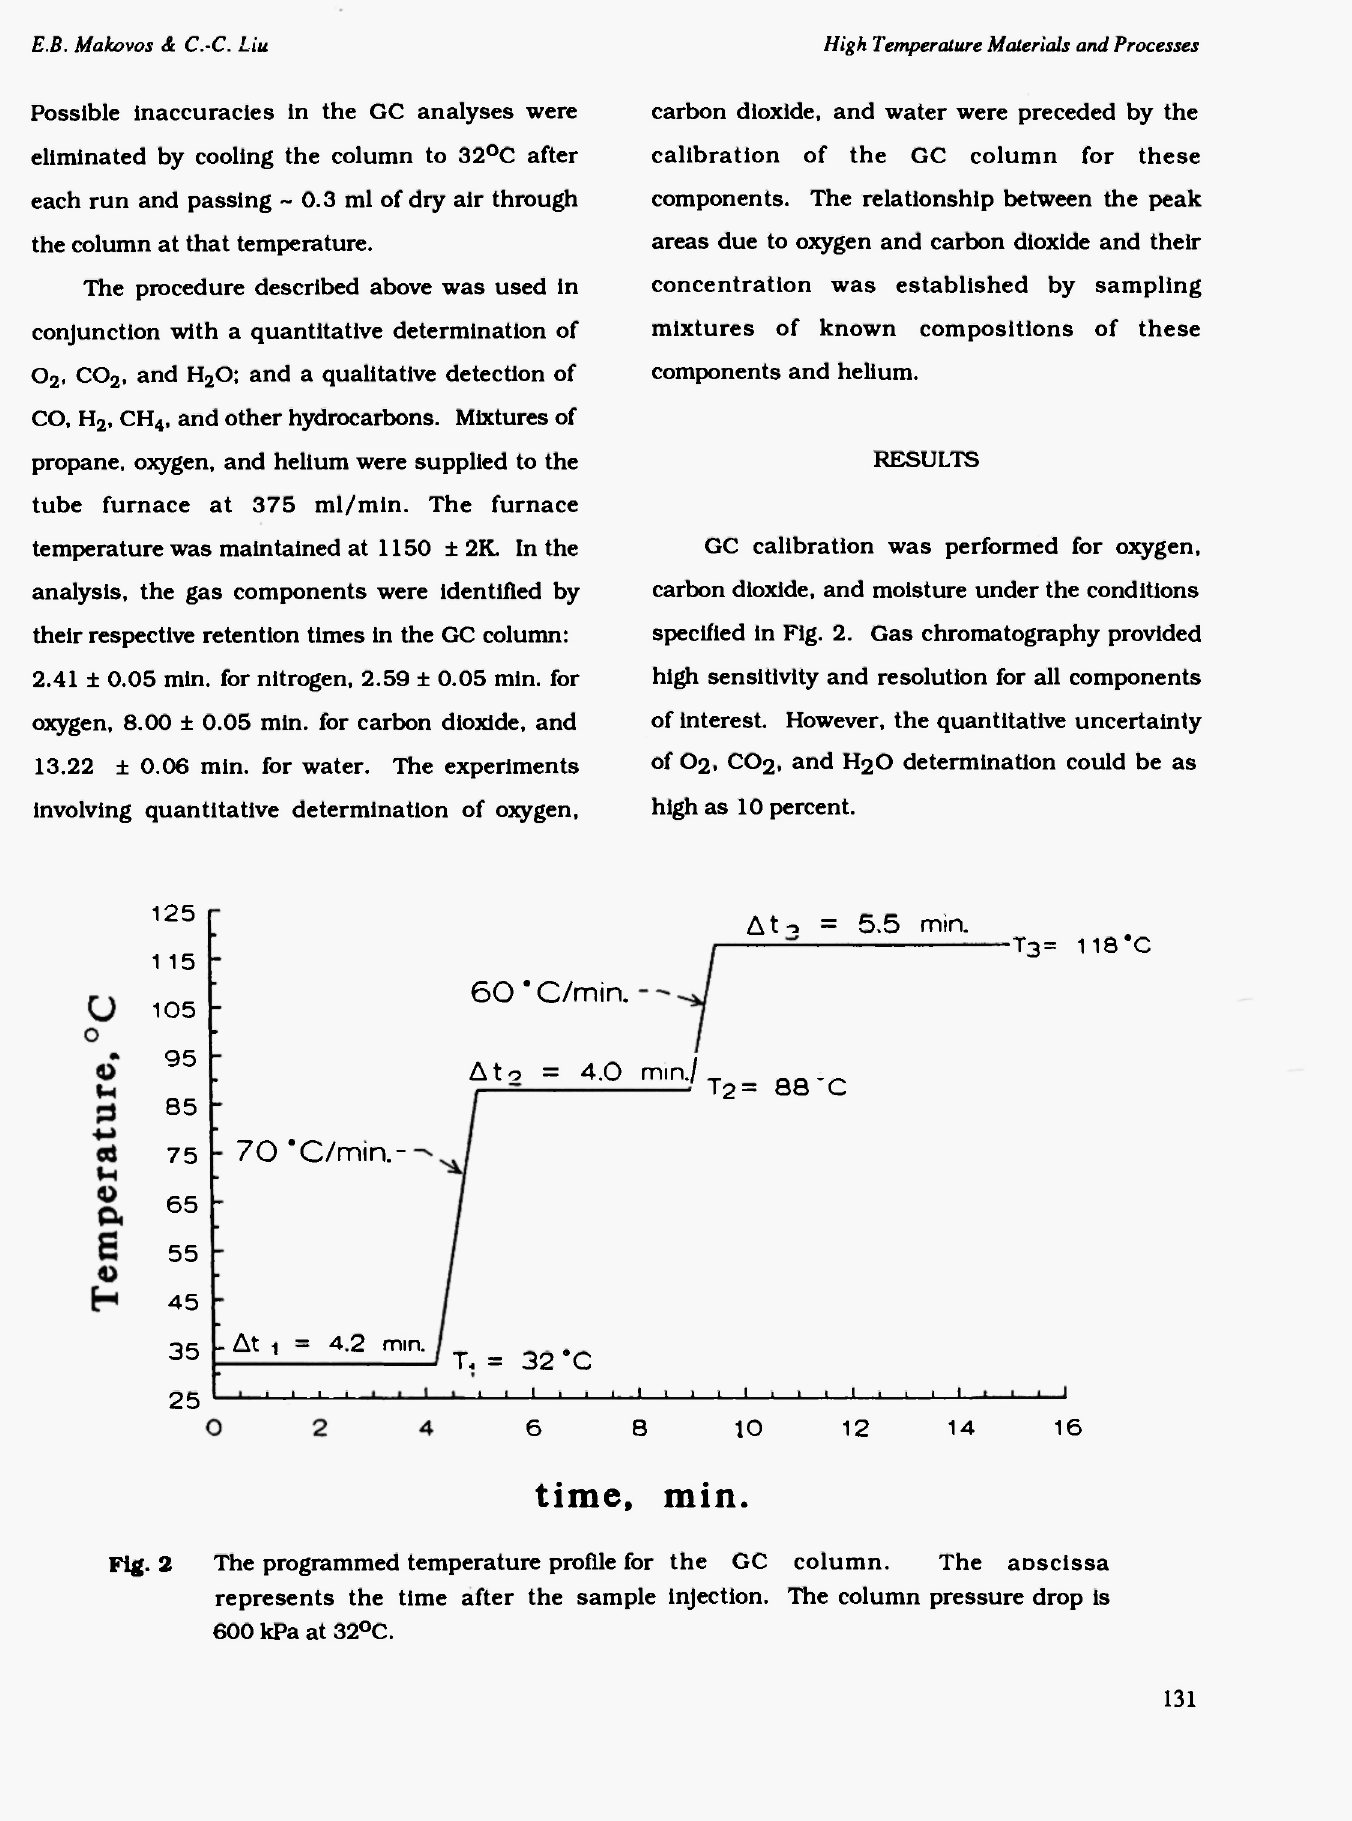
Fig. 2 The programmed temperature profile for the GC column. The aDscissa represents the time after the sample injection. The column pressure drop is 600 kPa at